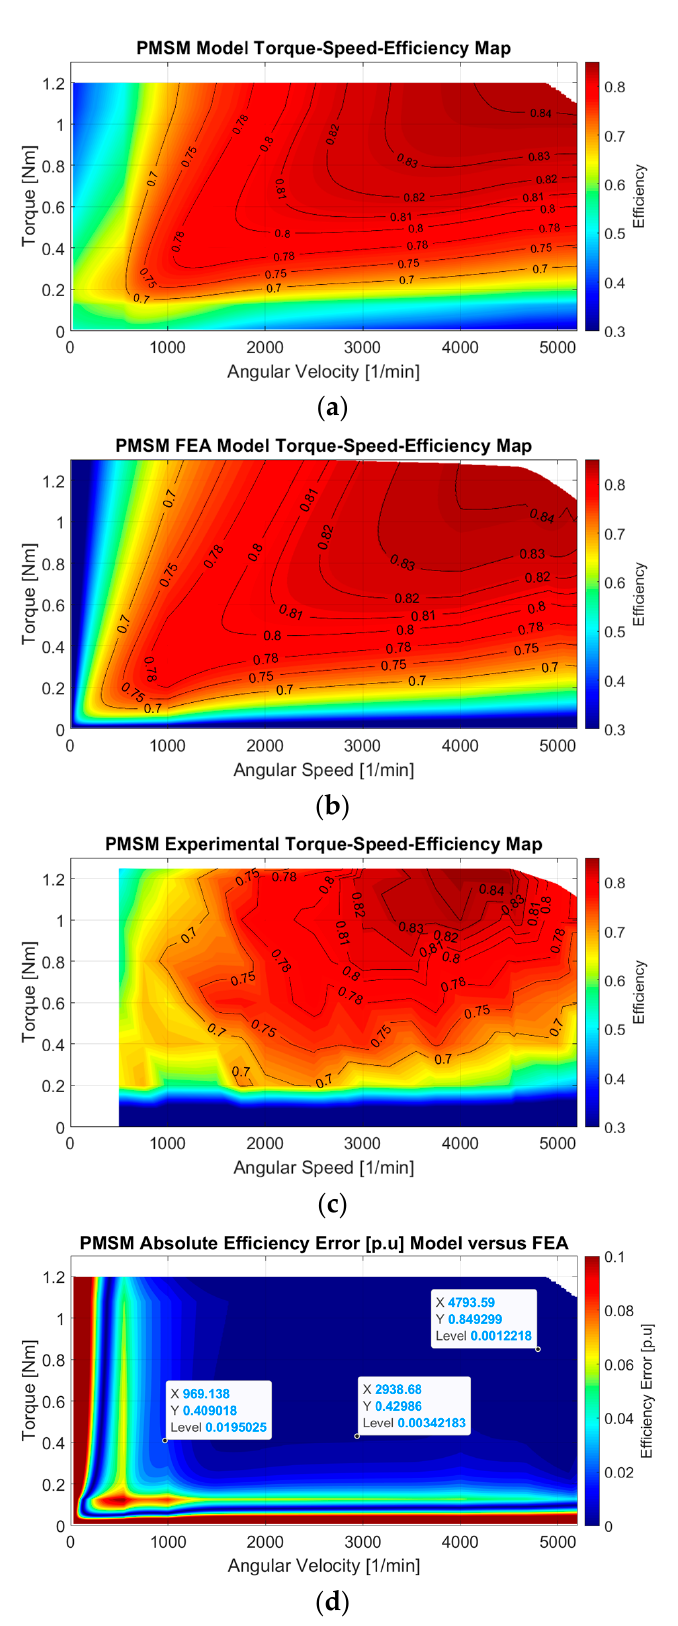
Figure 7. PMSM torque-speed-efficiency map. ( a ) Parameter estimation; ( b ) FEA ( c ); experimental measurement; (d) Efficiency error map